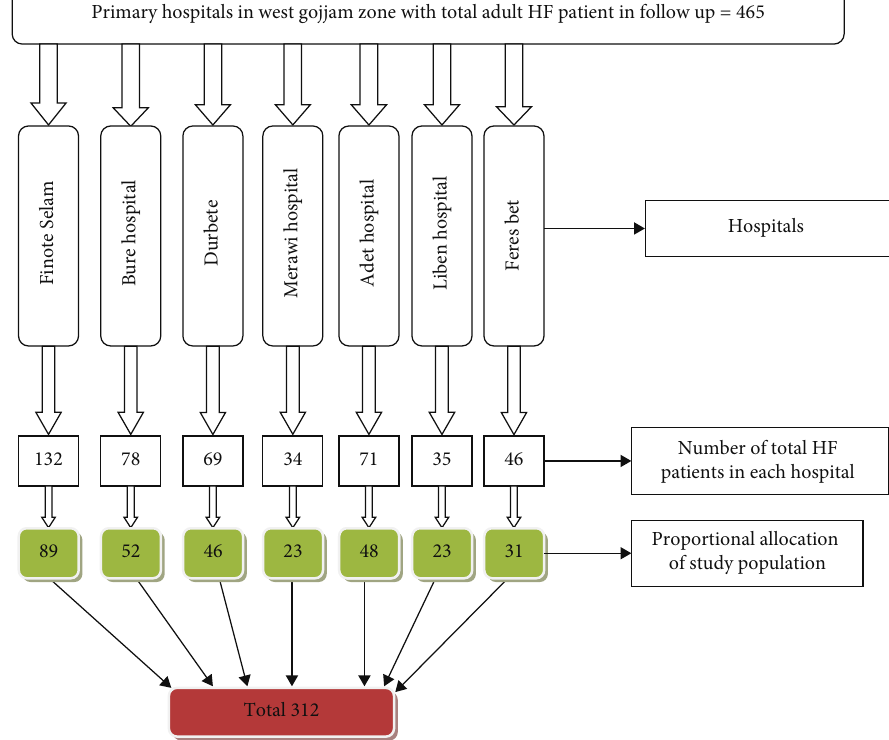
Figure 1: Sampling procedure to determine adherence to self-care recommendations and associated factors among heart failure patients in West Gojjam Zone public hospitals,